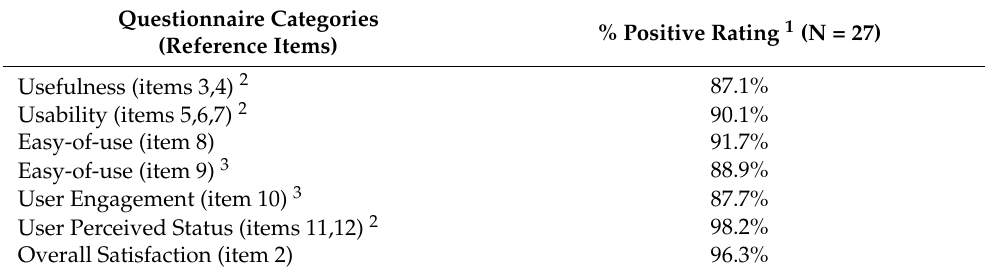
Table 5. Summary of positive rating percentages on the categories of the ad-hoc